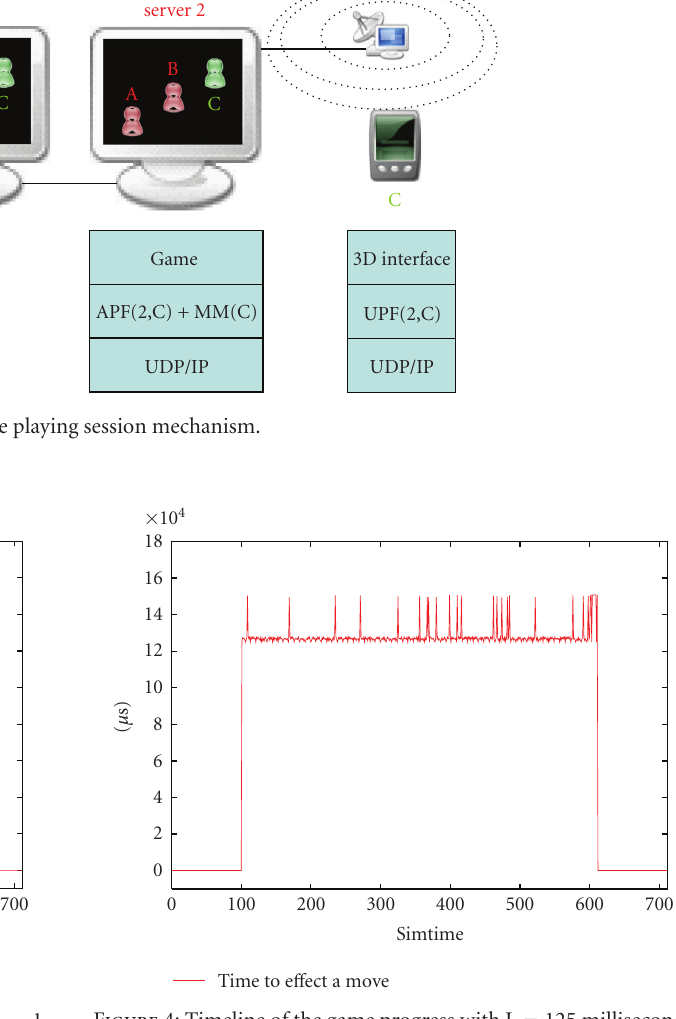
Figure 3: Timeline of the game progress with L = 125 milliseconds and PL = 0%.